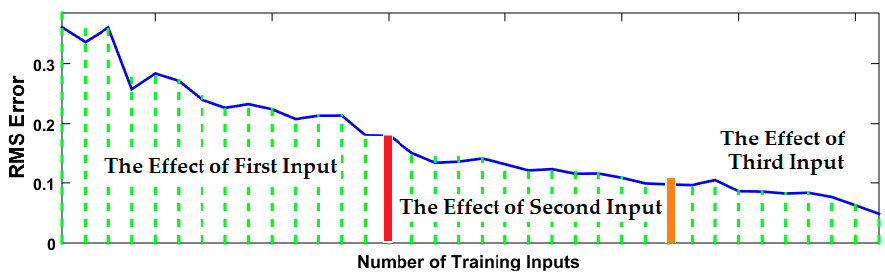
Figure 6. Effect of the SNFS on reducing the signal estimation error.